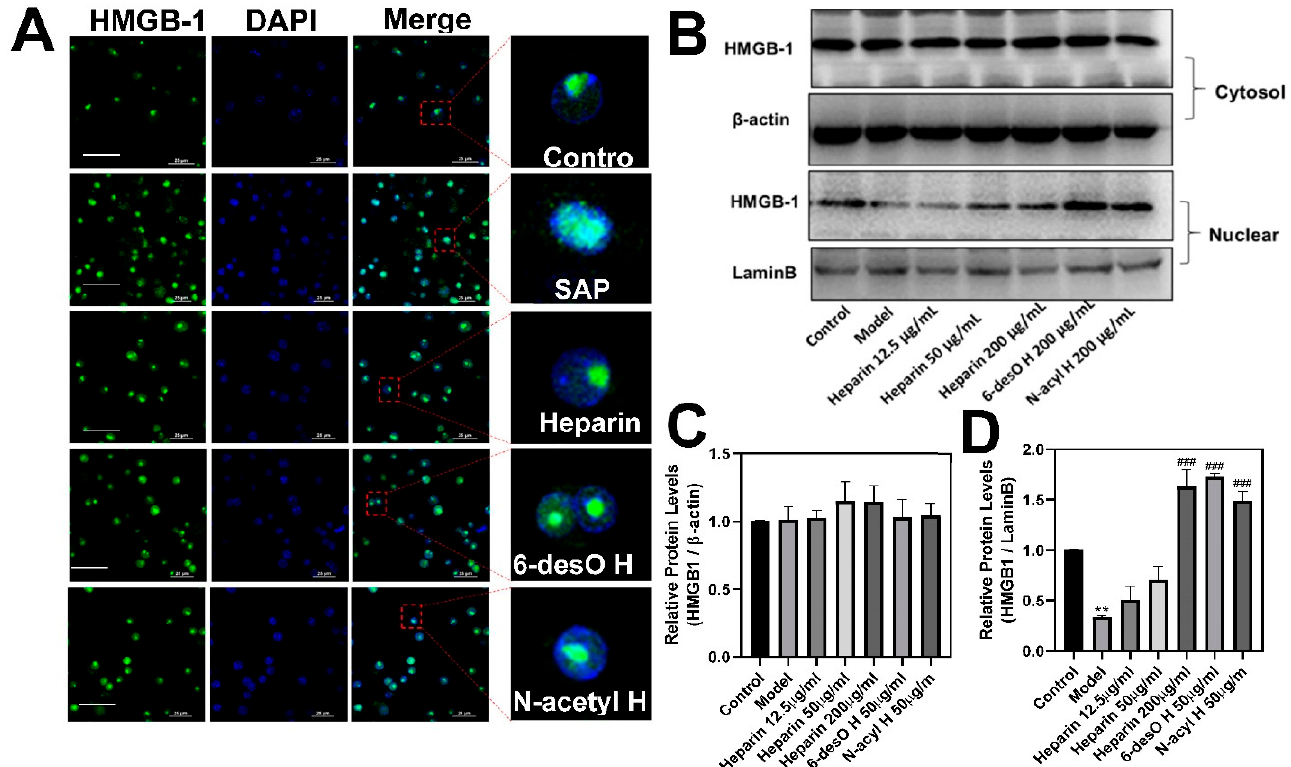
Figure 5. Heparin inhibited HMGB-1 secretion from activated RAW264.7 cell. ( A ) The HMGB-1 distribution in the cells was observed by immunofluorescence (green). The nucleus of the cells was labeled with DAPI (blue). The cells without treatment were regarded as the control group, whereas the SAP and drug groups were activated with the supernatant of the damaged pancreatic tissue of mice for 2 h in advance (Scale Bars = 20 µm). ( B ) The representative images of Western-blotting against HMGB-1 in the cytosol zone and nuclear zone of the cell. ( C ) The relative amount of HMGB-1 in the cytosol zone. ( D ) The relative amount of HMGB-1 in the nuclear zone (### p < 0.001, SAP vs. other groups; ** p < 0.01, SAP vs. control groups).